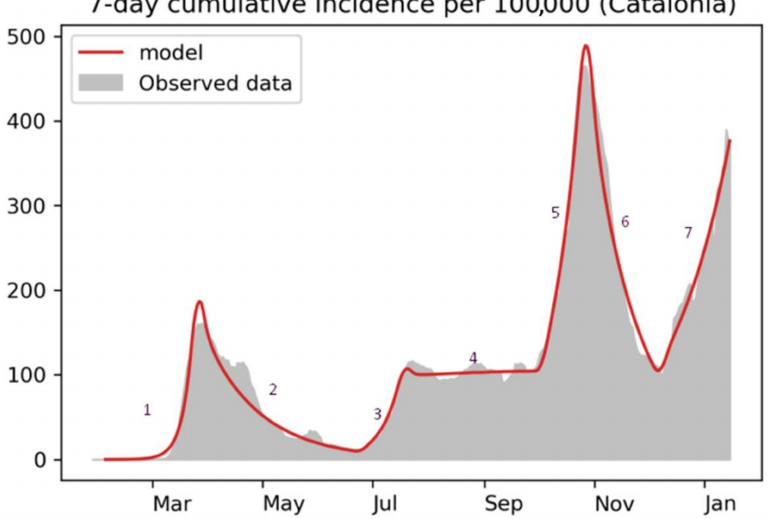
Figure 3. Fitting the changing points to detect regime shifts in the cumulative incidence curve (7 regimes in this